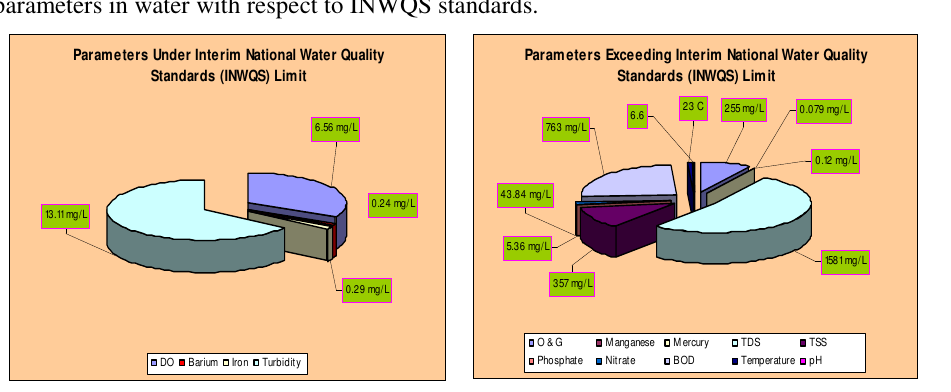
Figure 16. Parameters Exceeding Safe Water Quality limits Color